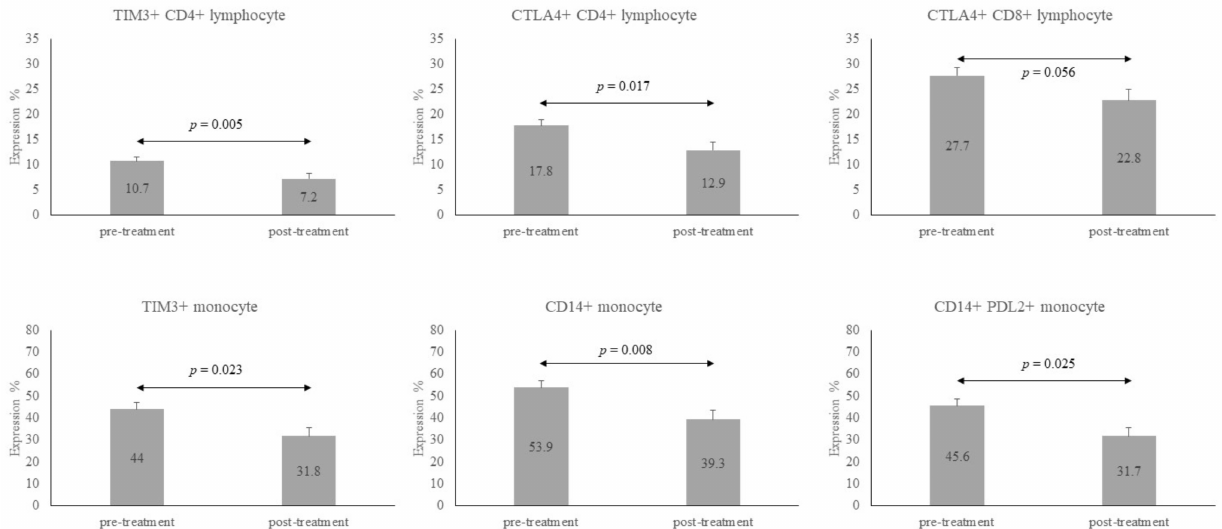
Figure 2. Bar chart to illustrate the dynamic changes of immune checkpoints and CD14+ monocytes before and after treatment of latent tuberculosis infection (LTBI). The number in the bars were the mean and the error lines represented mean of standard deviation. ↔ meant comparison of two groups. All these six subtypes of CD4+, CD8+, and monocytes were significantly decreased after LTBI treatment, except for CTLA4+ CD8+ lymphocyte, which was marginally significant. The data before treatment was compared to those after treatment by Wilcoxon pair test.